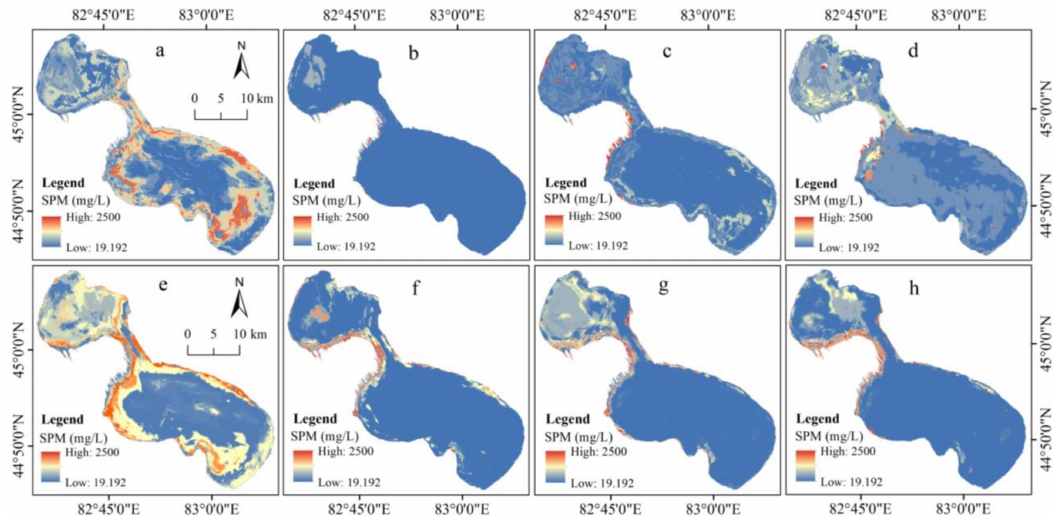
Figure 13. Results of the “fusion first” strategy: ( a ) ESTARFM (Landsat 8)_RF; ( b ) ESTARFM (Landsat 8)_XGBoost; ( c ) FSDAF (Landsat 8)_RF; ( d ) FSDAF (Landsat 8)_XGBoost; ( e ) ESTARFM (Sentinel 2)_RF; ( f ) ESTARFM (Sentinel 2)_XGBoost;